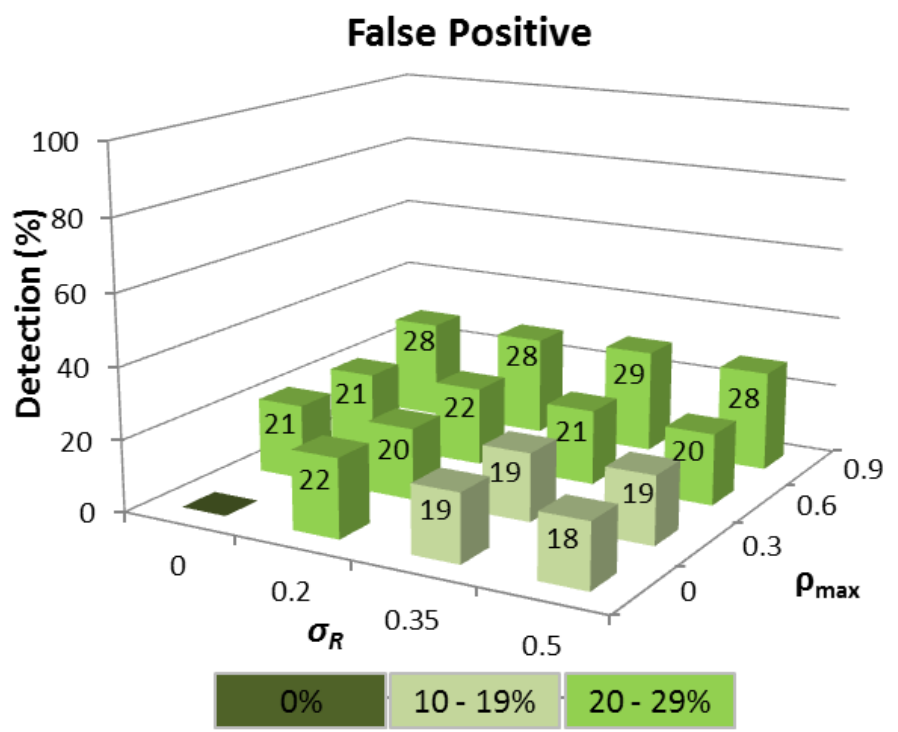
Figure 4. FP detection for different wormhole HC under variable network traffic loads ( ρ ) and routing packet service times ( σ max